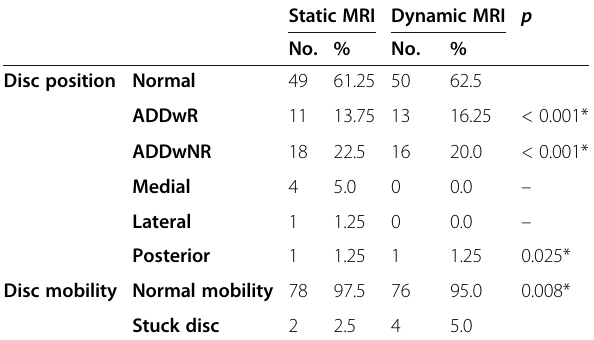
p : p value for chi-square test for association between static MRI and dynamic MRI *Statistically significant at p ≤